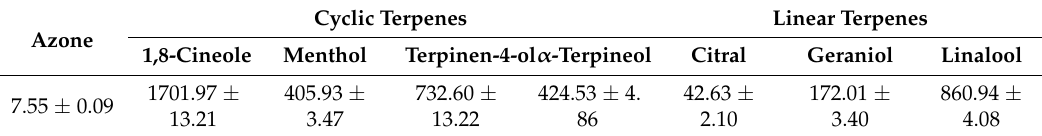
Table 6. The half maximal inhibitory concentration (IC 50 ) ( µ g/mL) values of oxygen-containing terpenes against HaCaT cells after 24 h incubation ( n = 6). Cyclic Terpenes Linear Terpenes Azone 1,8-Cineole Menthol Terpinen-4-ol α -Terpineol Citral Geraniol